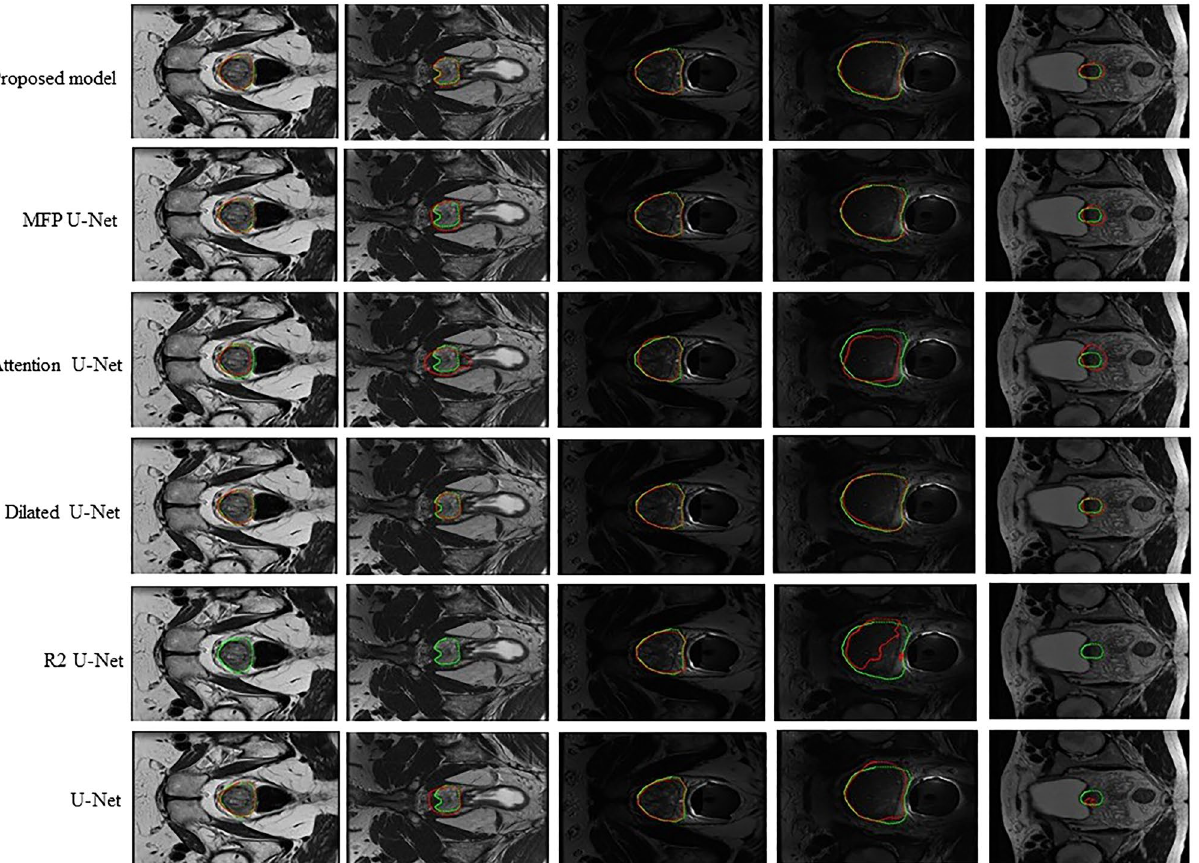
Figure 13. Representative results of segmentation achieved by the proposed model in comparison with other U-Net based models on multi-state MRI